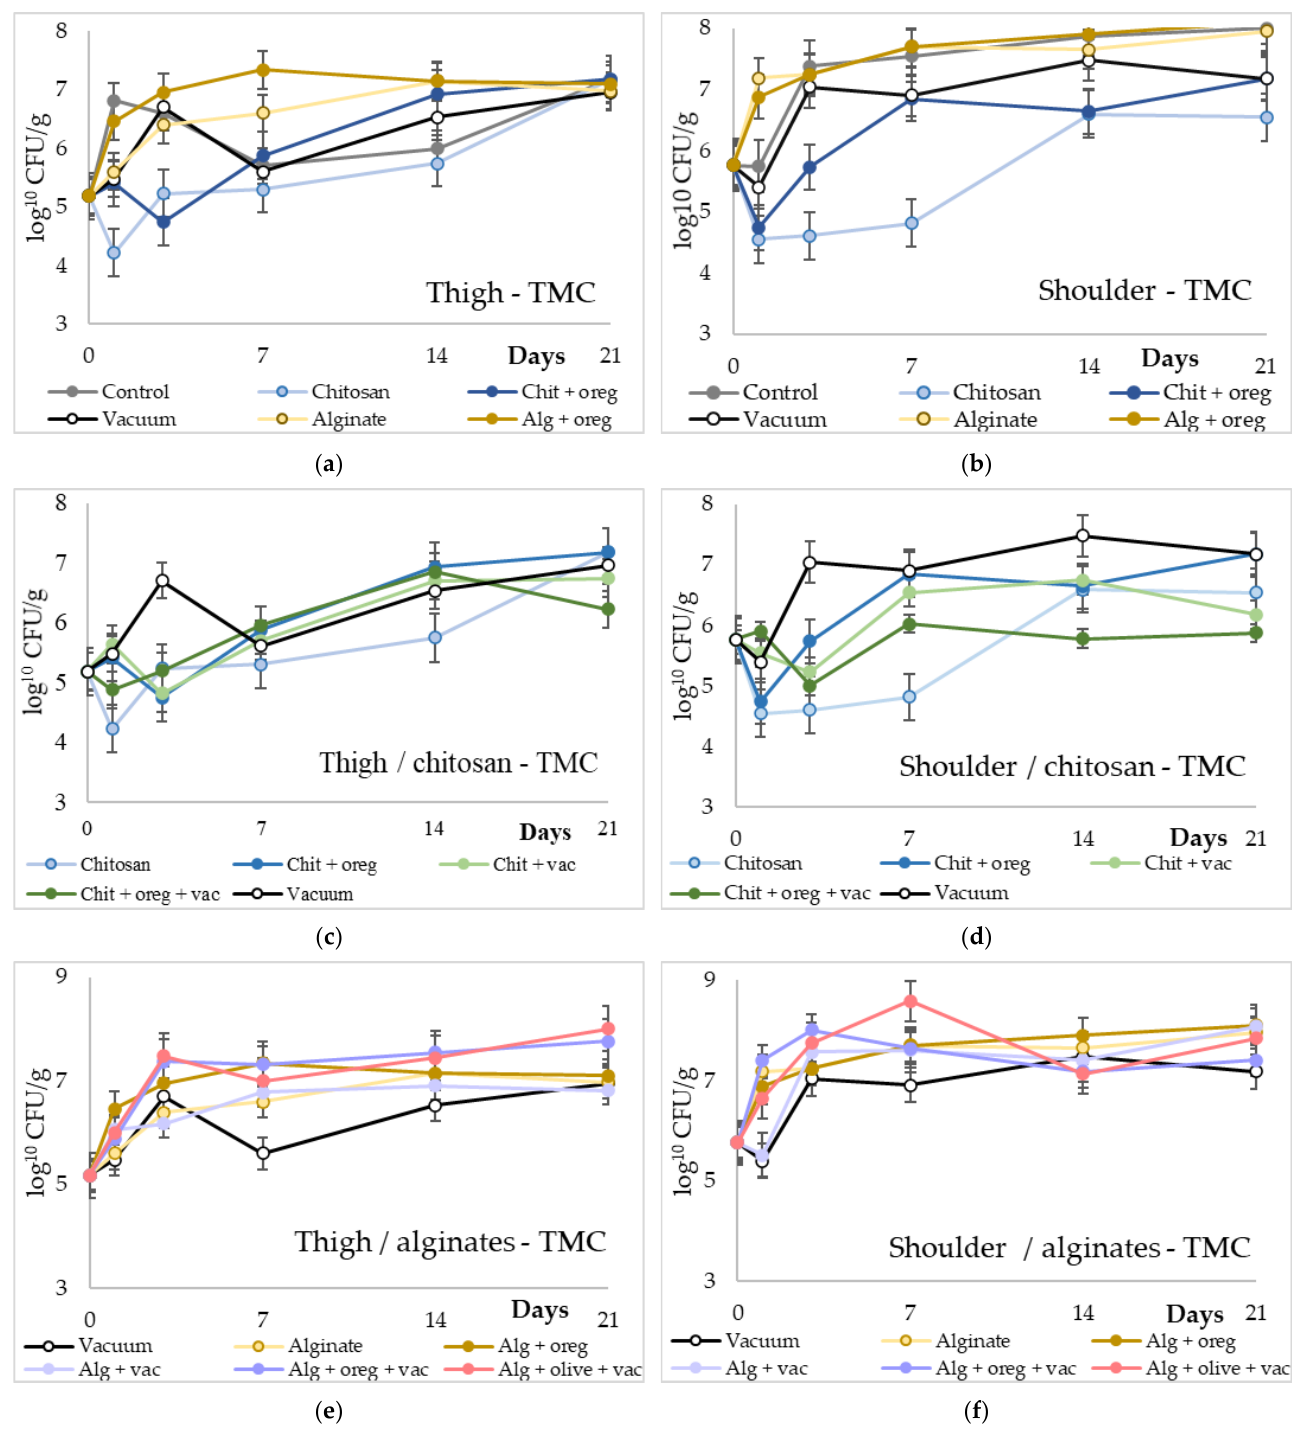
Figure 1. Total Mesophilic Counts (log10 cfu/g) of meat pieces over time (days). ( a , b ) TMC of control against chitosan or alginate coating with or without vacuum packaging in thigh and shoulder pieces; ( c , d ) TMC of different chitosan treatments in thigh and shoulder pieces; ( e , f ) TMC of different alginate treatments in thigh and shoulder pieces. (Chit: chitosan coating; oreg: oregano essential oil; vac: vacuum packaging; Alg: alginate coating; olive: olive oil addition).